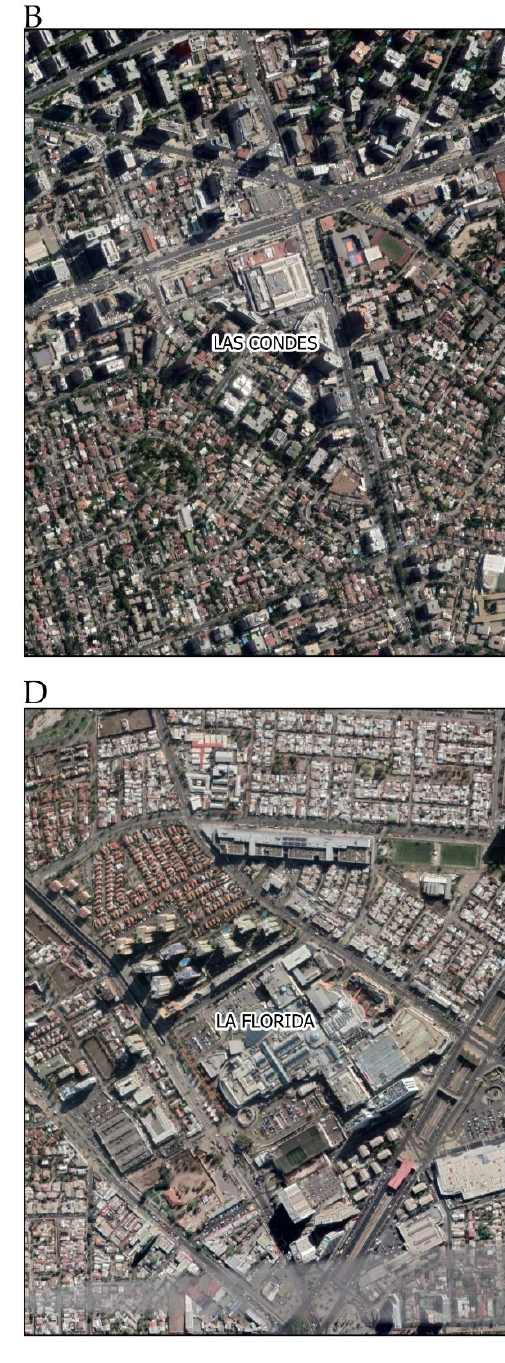
Figure A2. Neighborhoods indicated in Figure A1. Source: Google Earth 2020.